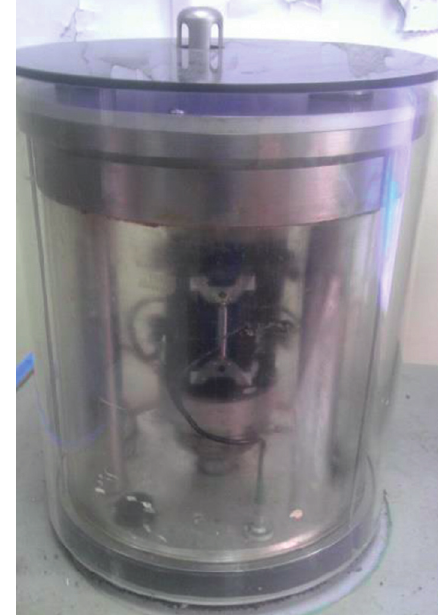
Figure 6: Testing results of asphalt concrete.